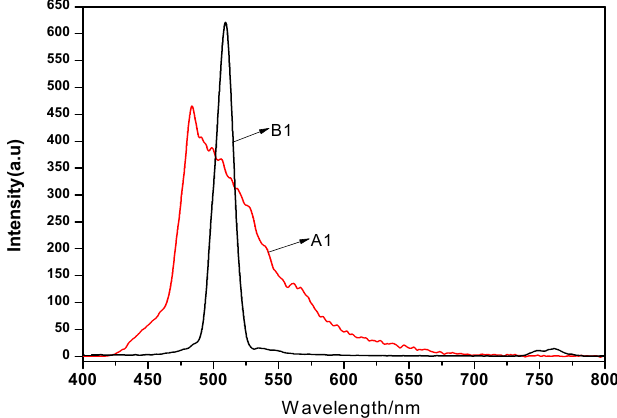
Figure 5. Emission spectra of A1 and B1 in dilute ethanol solutions at room temperature ( λ ex(max) = 239 nm, λ em(max) = 484 nm; λ ex(max) = 252 nm, λ em(max) = 508 nm).